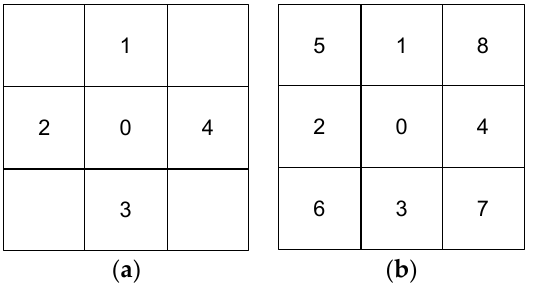
Figure 2. Schematic diagram. ( a ) Rook contiguity; ( b ) Queen contiguity.